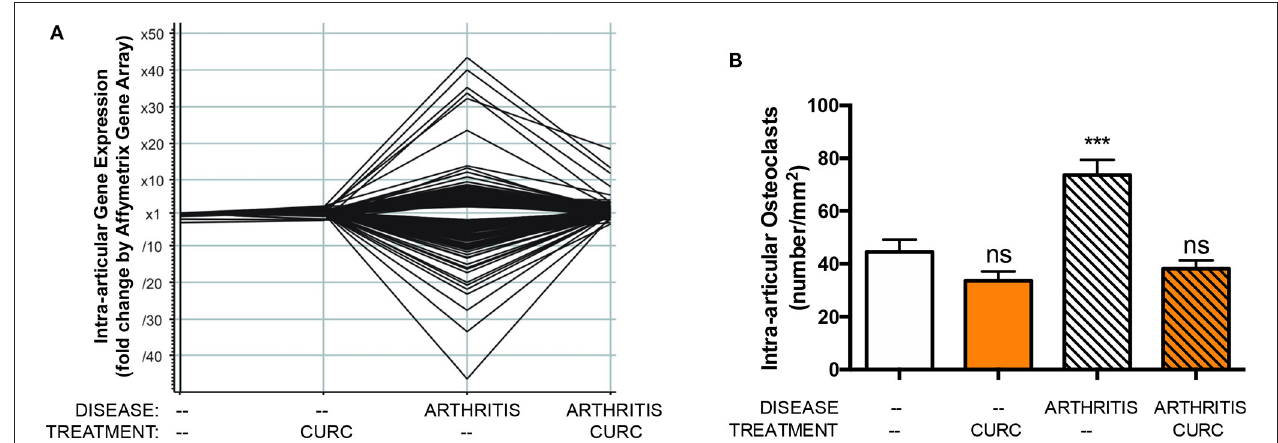
FIGURE 1 | In a pre-clinical arthritis model, consistent with curcuminoid blockade of intraarticular NF- κ B activation (not shown), curcuminoid (CURC) treatment significantly altered (A) gene expression in arthritic joints, including suppression of over 40 NF- κ B regulated genes, and (B) inhibited bone-resorbing osteoclast formation in arthritic joints, which is also NF- κ B mediated. ns, not significant or *** p < 0.001 vs. control (13).